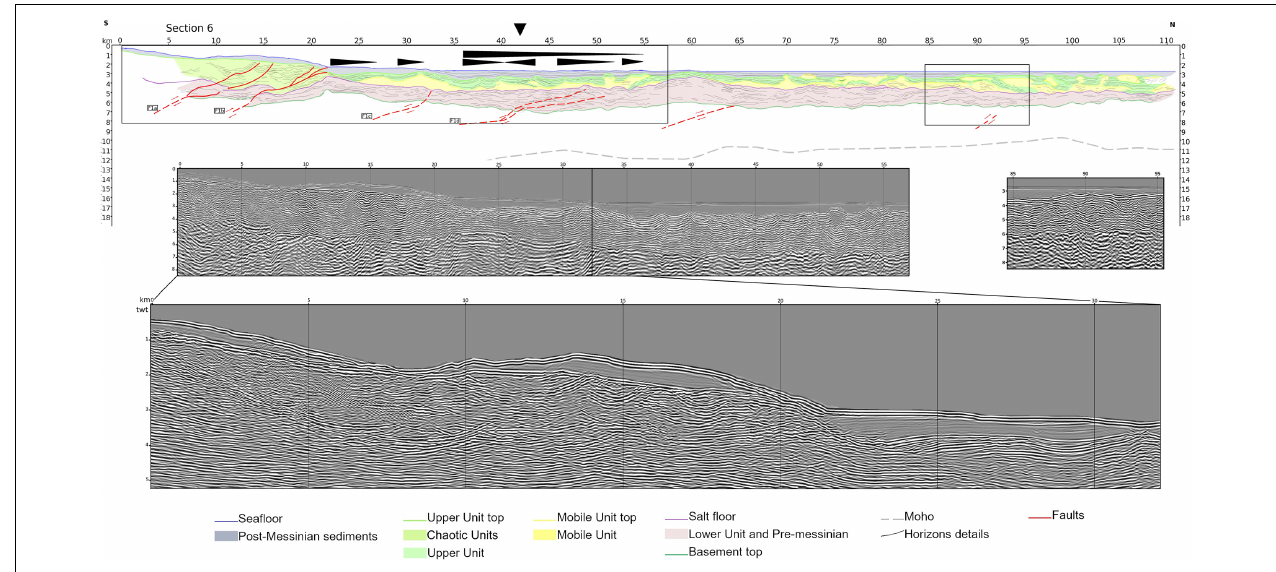
FIGURE 8 | Seismic Section 6 (Annaba) as a depth-converted line drawing. No vertical exaggeration. Major horizons and faults are identified, as well as major asymmetric basins. The insets display the raw depth-converted sections of the corresponding boxes. The inset on the second line is an extraction of the two-way-time section provided to better evidence faults-related shifts and the deformation of the sediments. Light green unit in the margin corresponds to the Messinian Complex unit (CU) coeval to UU and deposited in response to the major sea level drop of the Messinian Salinity Crisis. Stretched triangles: same as Figure 6 . Downward pointing arrow locates the ocean-continent